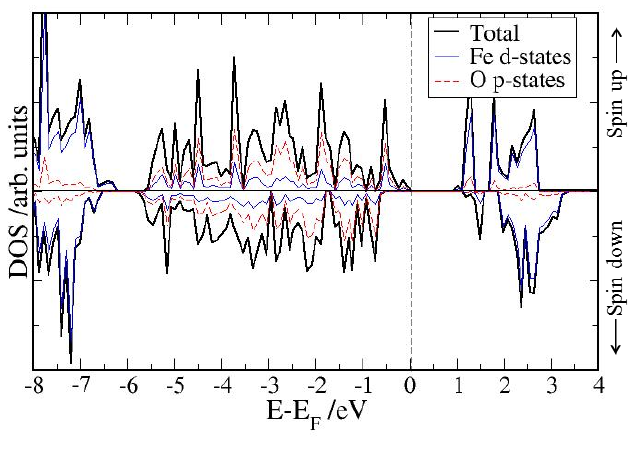
Figure 9. Density of states of the Fe level is set to zero as shown by the dashed